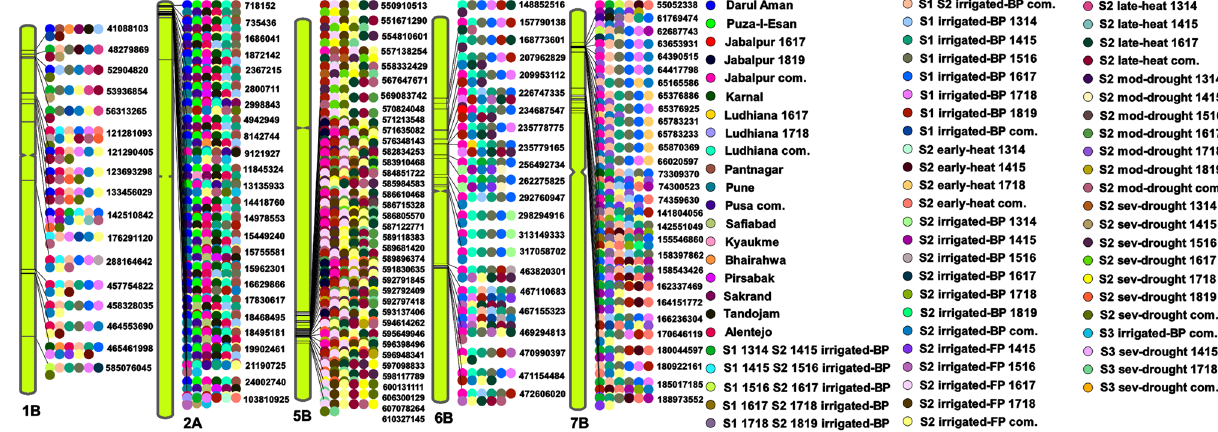
Figure 6. A reference grain yield-associated markers map aligned to the reference sequence of bread wheat (RefSeq v.1.0), with 130 grain yield-associated markers on chromosomes 1B, 2A, 5B, 6B and 7B, that were consistently associated in seven to twenty-four datasets. The reference map was visualized using Phenogram (http://visua lizat ion.ritch ielab .org/pheno grams /plot). The datasets in which the markers were significantly associated with grain yield included: Darul Aman (Afghanistan); Puza-I-Esan (Afghanistan); Jabalpur (India); Karnal (India); Ludhiana (India); Pantnagar (India); Pune (India); Pusa (India); Safiabad (Iran); Kyaukme (Myanmar); Bhairahwa (Nepal); Pirsabak (Pakistan); Sakrand (Pakistan); Tandojam (Pakistan); Alentejo (Portugal); best-linear unbiased estimates of Stage 1 (S1) and Stage 2 (S2) yield trials evaluated in the irrigated-bed planting (irrigated-BP) environment at Obregon (Mexico); Stage 1 (S1) yield trials evaluated in the irrigated-BP environment at Obregon; Stage 2 (S2) yield trials evaluated in the early-heat (S2 early-heat), irrigated-bed planting (S2 irrigated-BP), irrigated-flat planting (S2 irrigated-FP), late-heat (S2 late-heat), moderate-drought (S2 mod-drought) and severe-drought (S2 sev-drought) environments at Obregon; and Stage 3 (S3) yield trials evaluated in the irrigated-BP (S3 irrigated-BP) and severe-drought (S3 sev-drought) environments at Obregon. The names of the environments in the datasets are followed by the crop